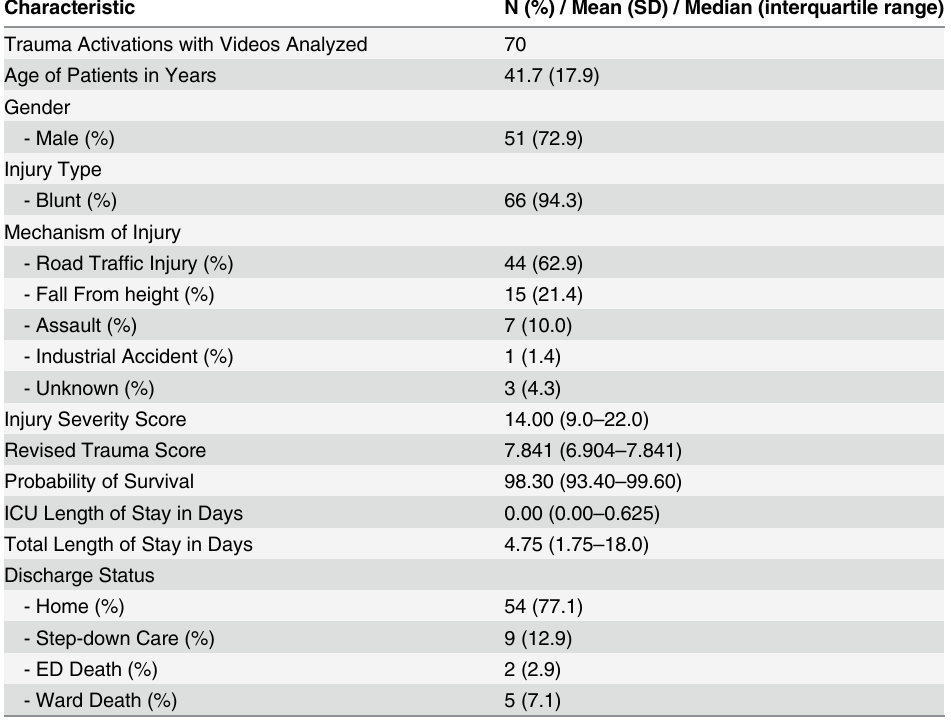
Table 1. Population and Injury Demographics.